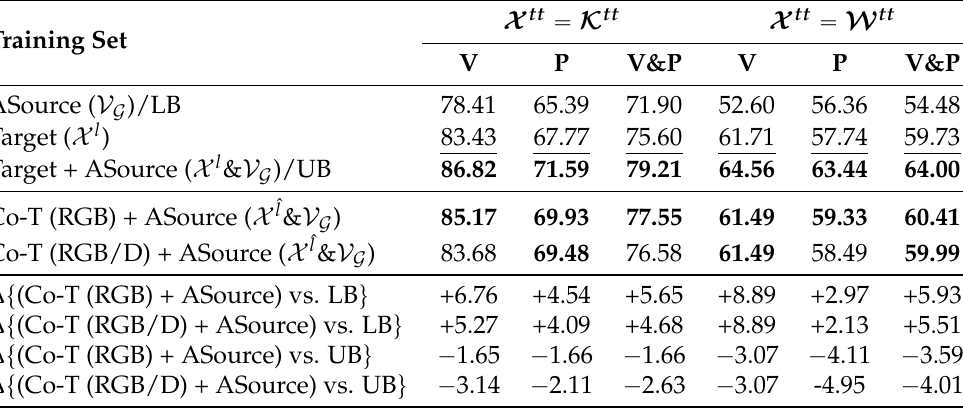
Table 6. SSL (co-training) results on vehicle (V) and pedestrian (P) detection, after GAN-based virtual- to-real image translation, reported as mAP. ASource (adapted source) refers to V G P t V G X ˆ l , Source, Co-T (RGB), Co-T (RGB/D), UP, LB, ∆ t φ analogous to those in Table